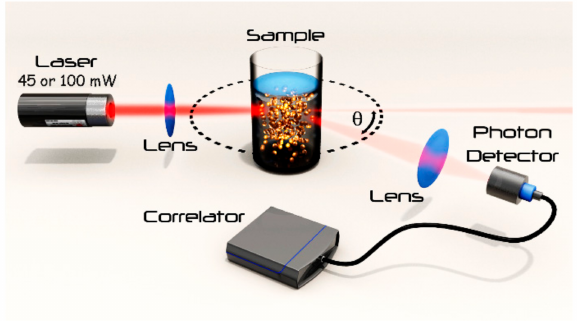
Figure 1. Depiction of the dynamic light scattering (DLS) apparatus with two different lasers of nominal powers 45 mW, and 100 mW, respectively. The sample is only schematically depicted to visualize the measurement